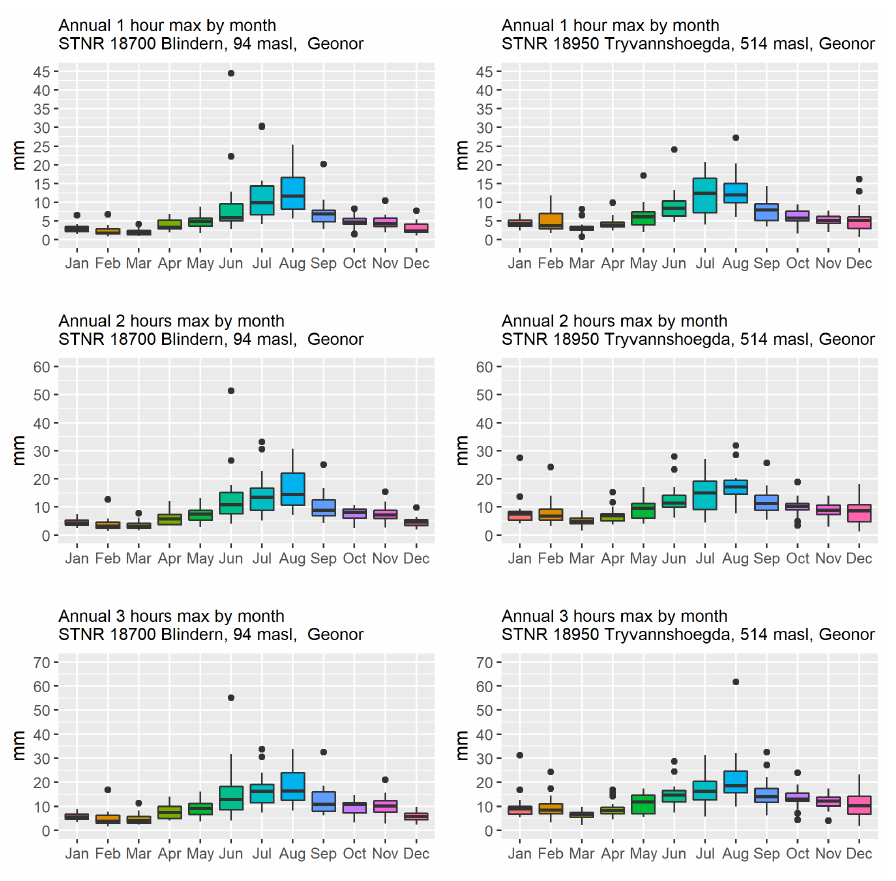
Figure 2. Annual maximum of 1, 2, and 3 h precipitation by month at the stations 18700 Oslo-Blindern and 18950 Tryvannshøgda. See Figure 1 for station